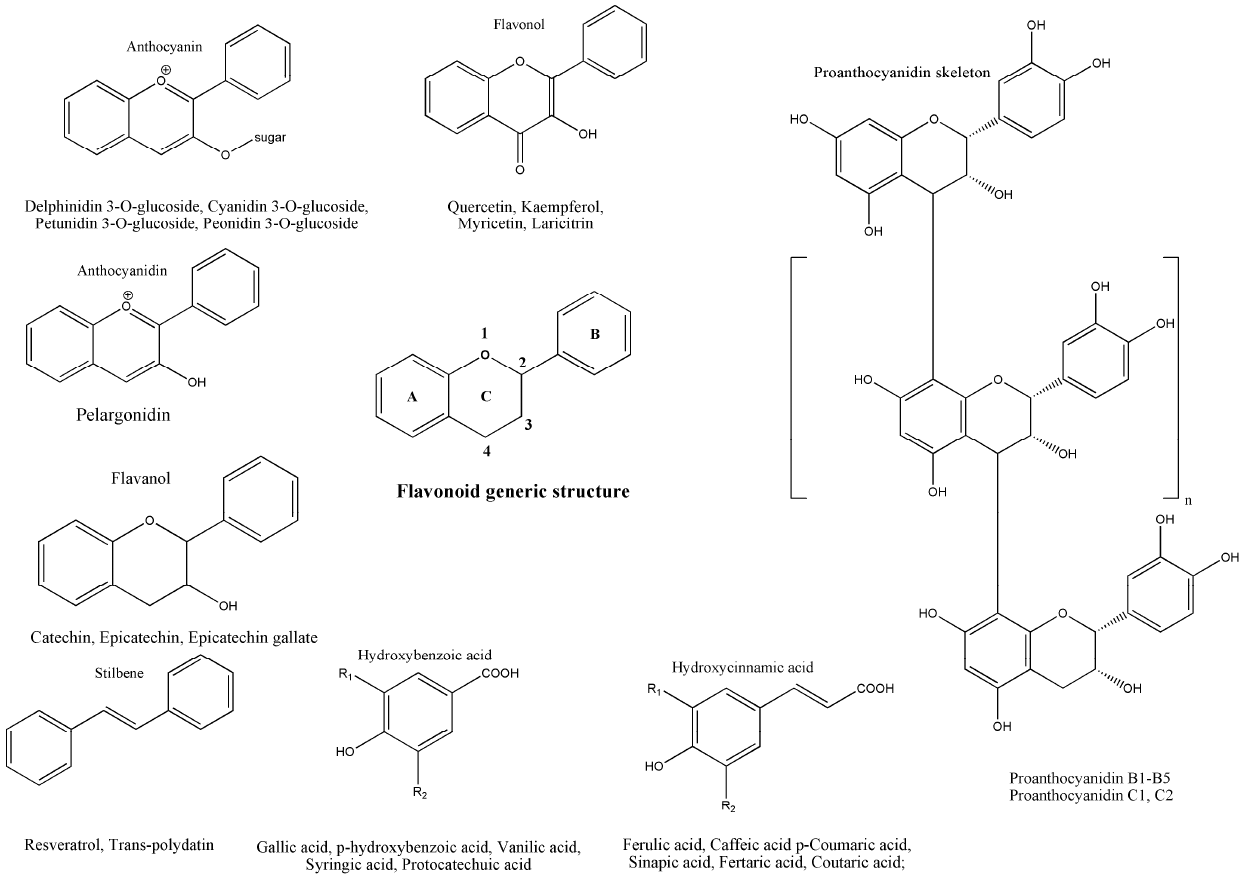
Figure 2. Flavonoid generic structure, structures of the main grape pomace polyphenols classes, as well as the most representative compounds.